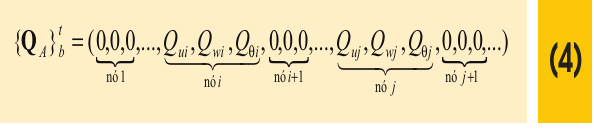
trated in figure 2. In straight elements the local origin coincides with node i and the x axis aligns with the chord i – j . The angle between the b